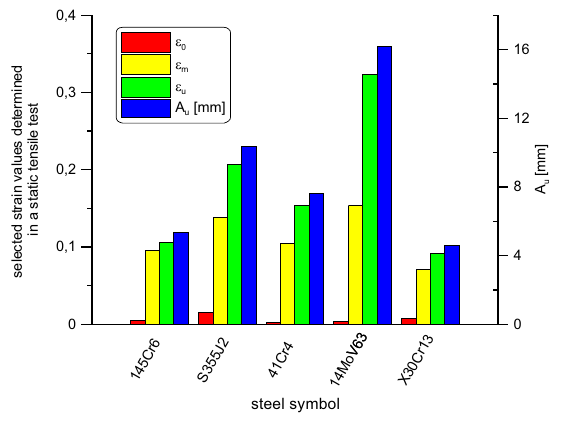
Figure 5: Comparison of the selected strain values determined in the static tensile test and elongation A u for all steels used in the